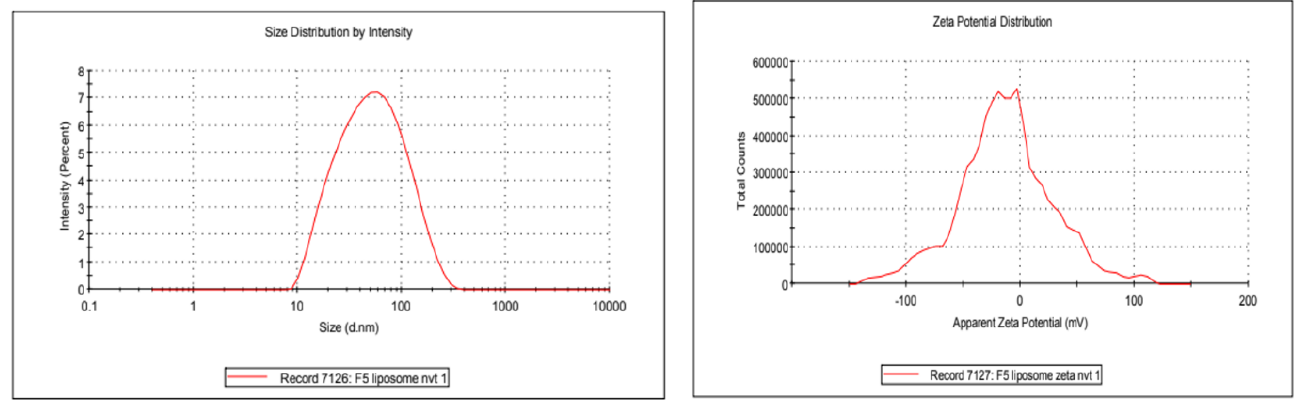
Figure 4. Vesicle size distribution and zeta potential of optimized transferosome - loaded proanthocyanidin.